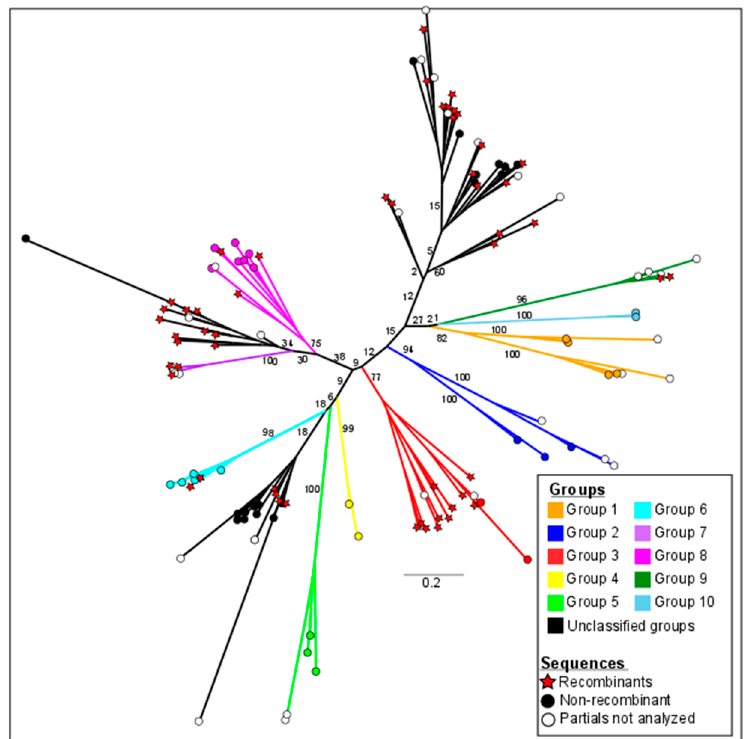
Figure 2. Phylogeny and classification of transcribed RHS sequences. Phylogenetic analysis was carried out using the RaxML v 8.2.9 program with an automatic search for substitution models (PROTGAMMAAUTO) selected using the Akaike information criterion (AIC) (auto-prot = AIC), with 1000 bootstrap replicates. Groups 1–10 comprise RHS sequences, with supported values separated by colors, and RHS sequences with bootstrap values below the cutoff (unclassified groups) are indicated in black.